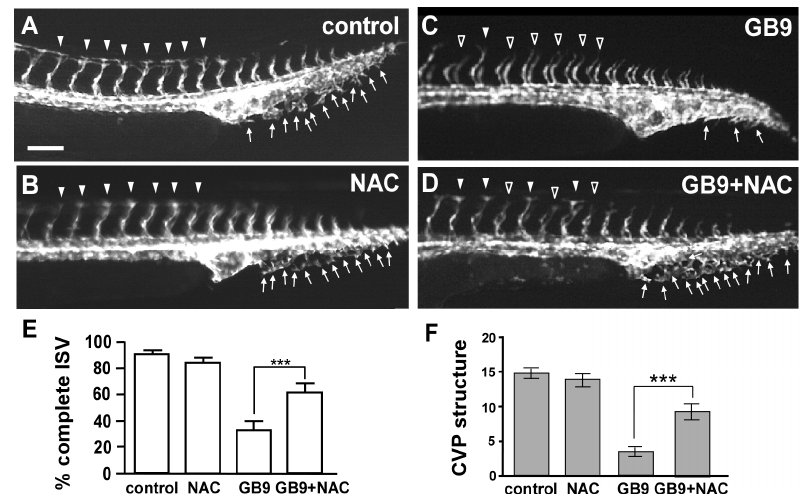
Figure 7. N -acetyl-cysteine (NAC) treatment rescues the vascular defects in GB9-treated embryos. ( A , B ) At 28 hpf, in untreated controls and 50 μ M NAC-treated embryos, ISVs reached the DLAV at the embryo’s dorsal aspect ( arrowheads ) and endothelial sprouting at the CVP and some formed loop structures at the tail ( arrows ). ( C ) At the same stage, in GB9-treated embryos, ISVs showed slow growth mid-somite ( hollow arrowheads ) and less sprouting or loop formation at the CVP ( arrows ). ( D ) Exogenous 50 μ M NAC exposure restores the vascular defects of ISV and CVP in GB9-treated embryos. ( E ) Percentages of completed ISV are respectively ~91 ± 2.2, 85 ± 2.9, 33 ± 5.9, and 62 ± 5.1 in controls, NAC treatment, GB9 exposure and rescued embryos. ( F ) Quantification of CVP structures respectively showed ~14.8 ± 0.8, 13.7 ± 0.9, 3.5 ± 0.8, and 9.2 ± 1.1 in controls, NAC treatment, GB9 exposure and rescued embryos. *** refers to p < 0.0001 by one-way ANOVA followed by Tukey’s post-test. Data represent means ± S.E. Scale bars are 100 μ m for ( A – D ).